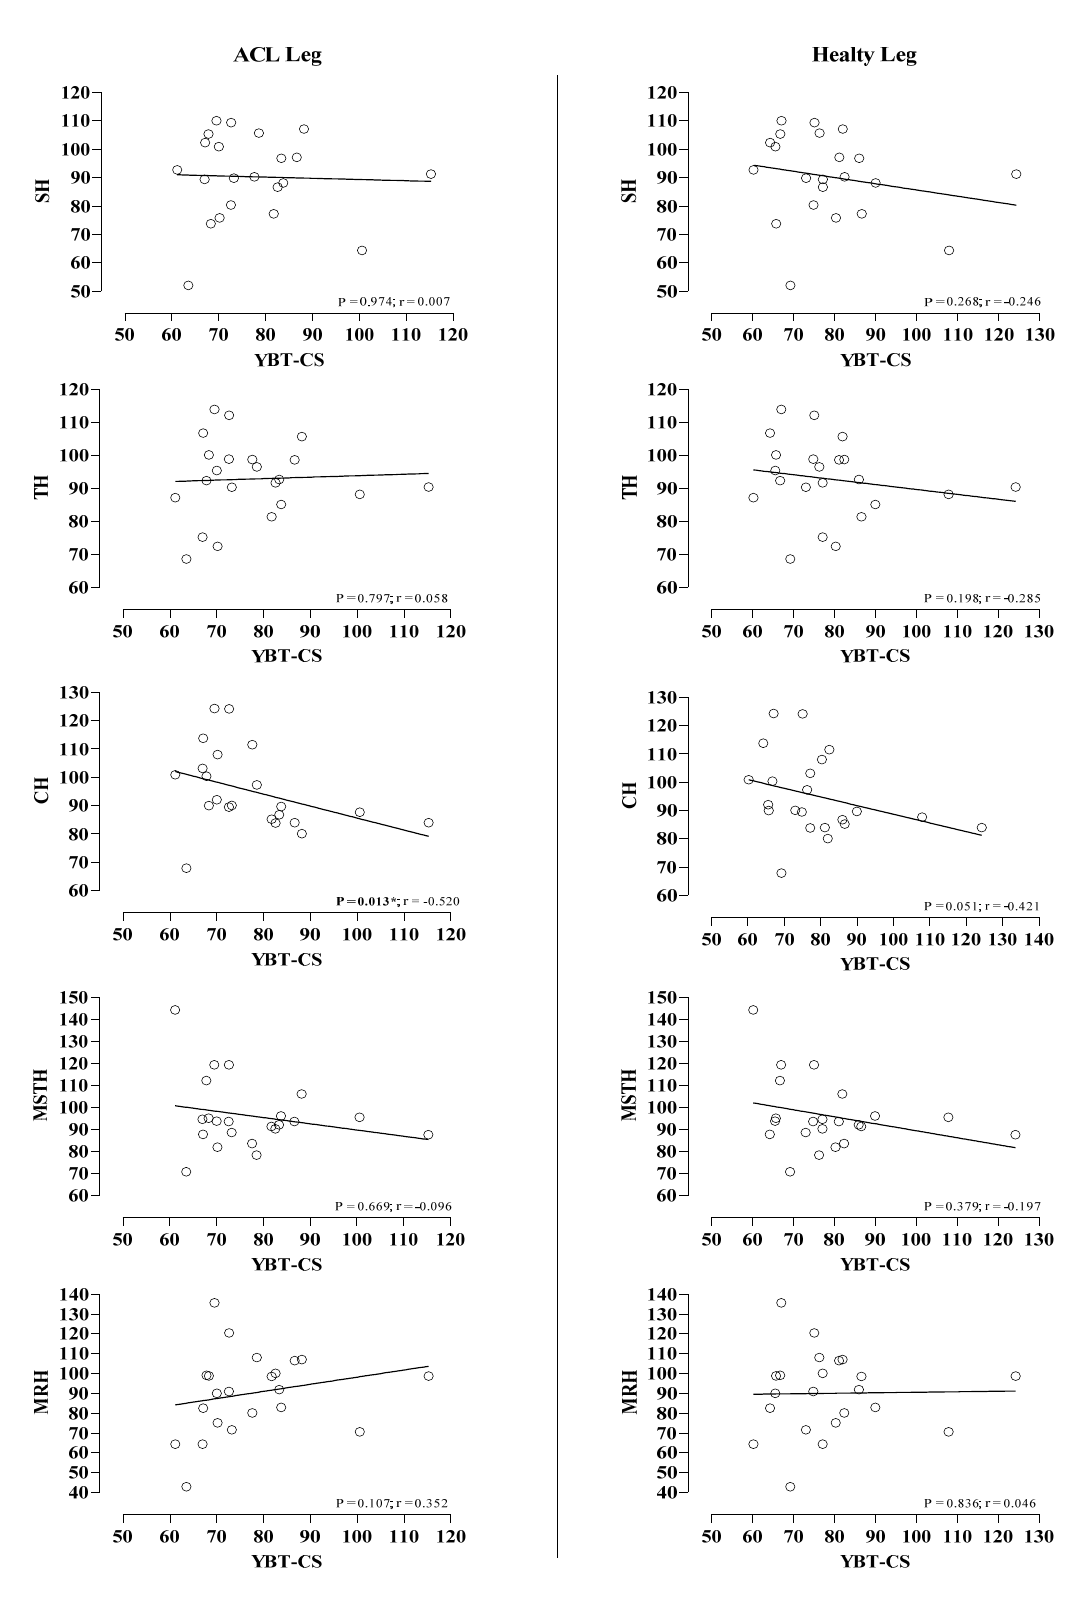
Figure 6. Correlation between YBT (composite score) and SLHT scores in operated (ACL-Leg) and healthy legs.